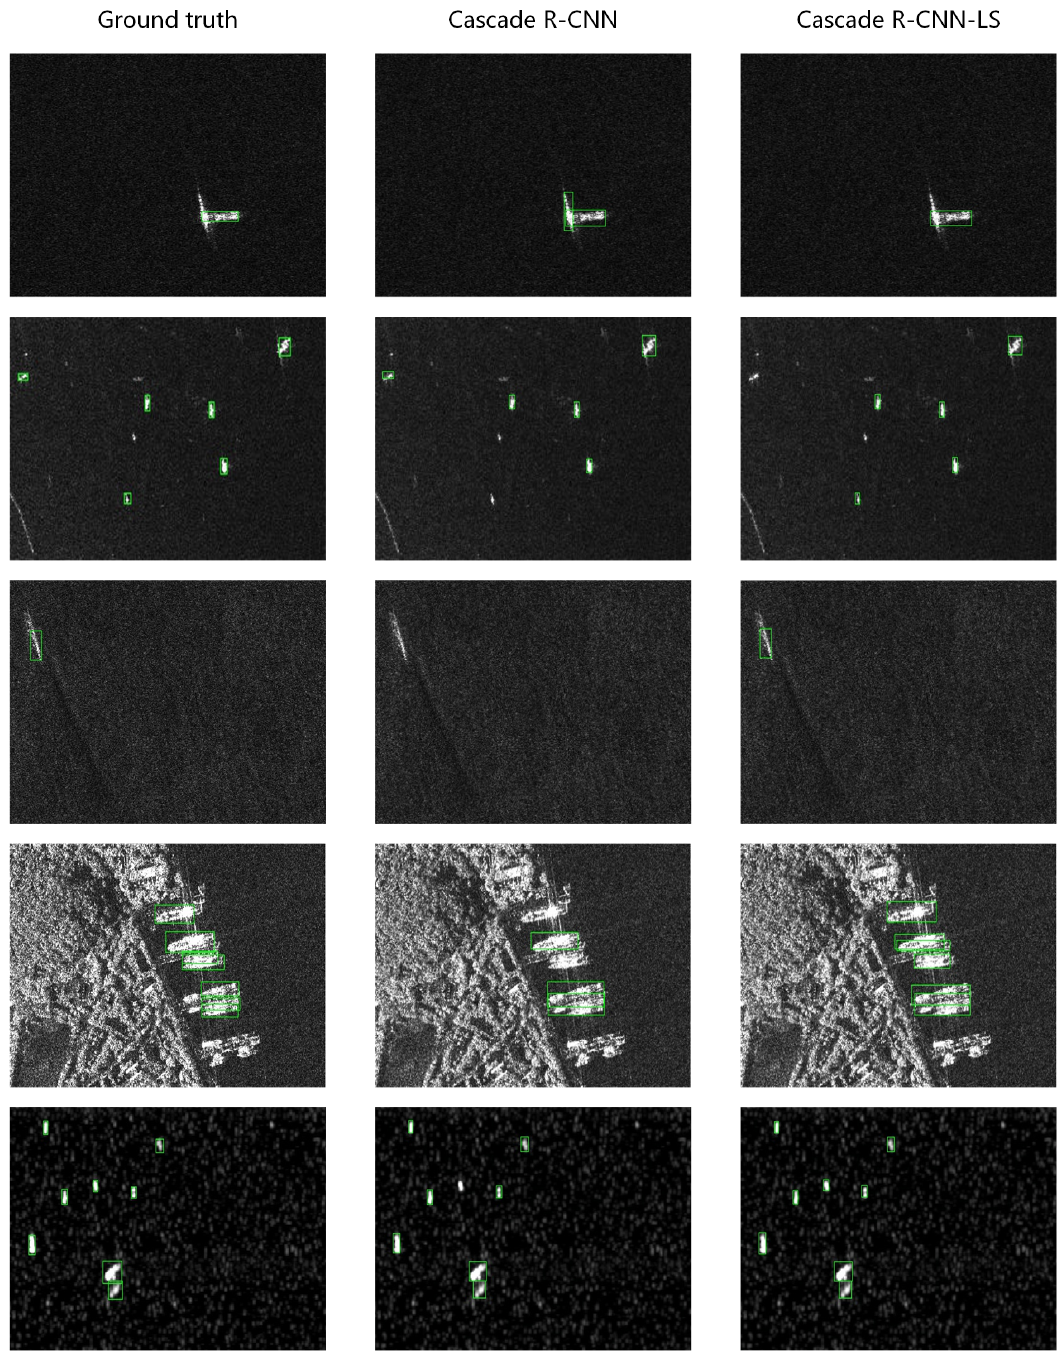
Figure 6. Detection results on SSDD samples. The 1st column displays the samples from the ground truth, while the 2nd and 3rd columns are the detection results of the relative samples of Cascade R-CNN and Cascade R-CNN-LS, respectively. The lifting scheme-based network tends to detect small objects better than the strided convolution as the 2nd and the 5th rows